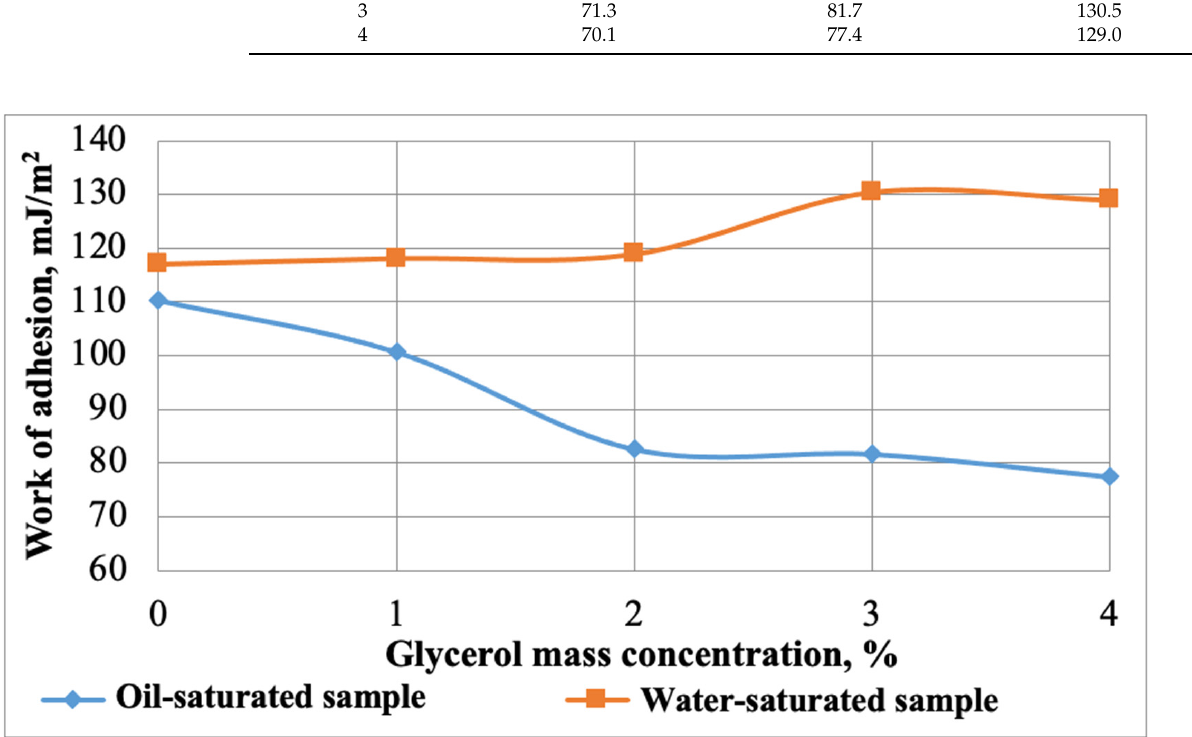
Figure 6. Correlation between the work of adhesion and the glycerol concentration in the shutoff composition at oil- and water-saturated rock samples.